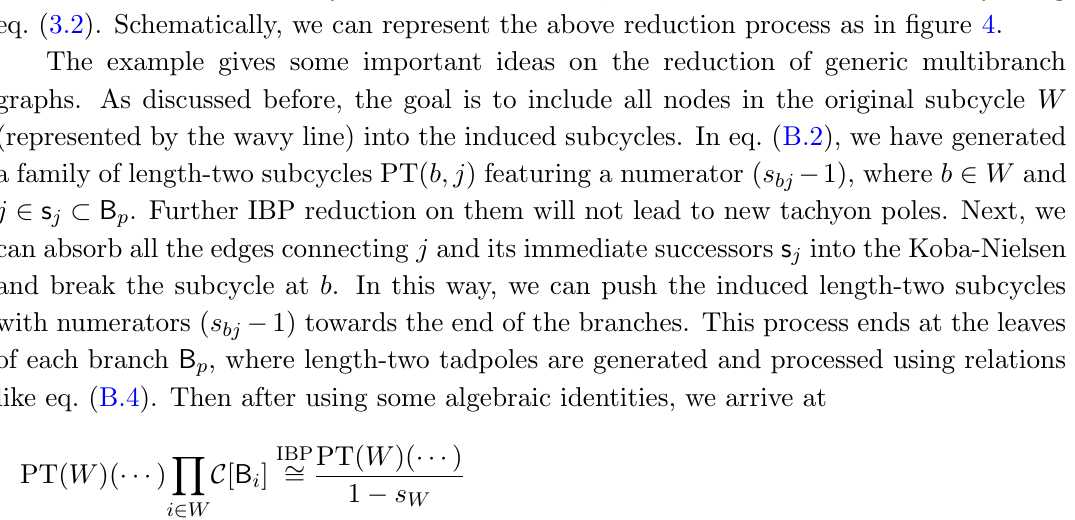
Figure 4 . The IBP reduction of PT( W ) 1 to the